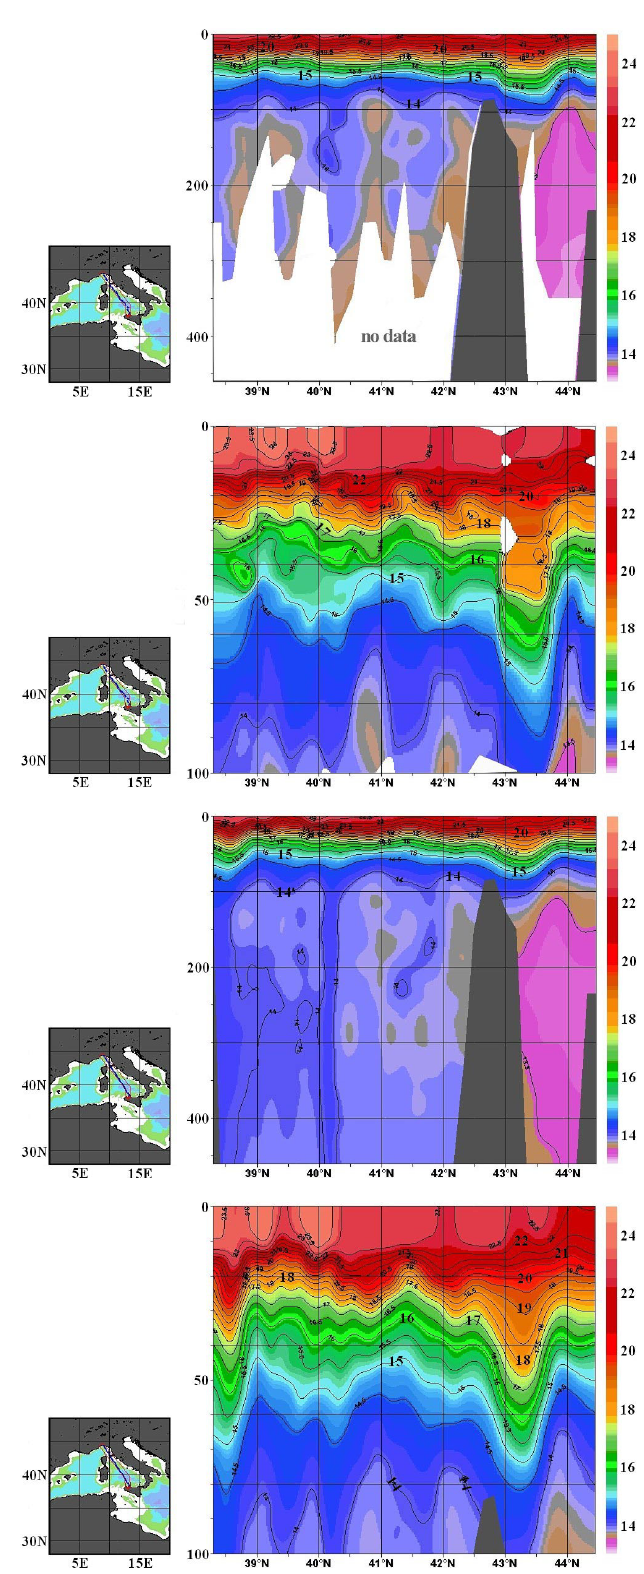
Fig. 8. Temperature section from Genova to Palermo obtained from decimated data ( (a) the data from surface down to the maximum depth, (b) the upper 100 metres) and from full resolution data ( (c) the full profiles from surface to the 460 metres maximum depth, (d) the upper 100